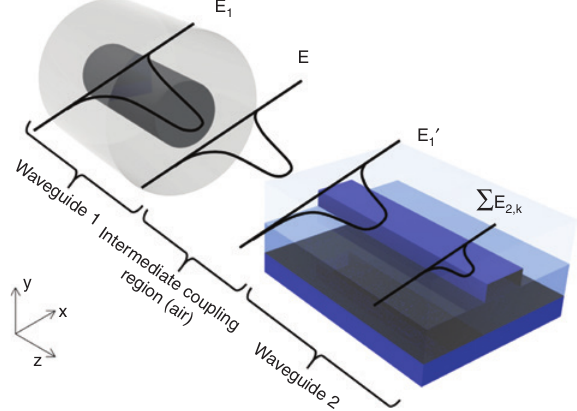
Figure 2: Schematic diagram of the end-fire coupling process between two waveguides. The input guided mode in the waveguide 1 ( E mode in the SMF); incoming electromagnetic field after passing through the intermediate coupling region ( E in the waveguide 2 ( ∑ E